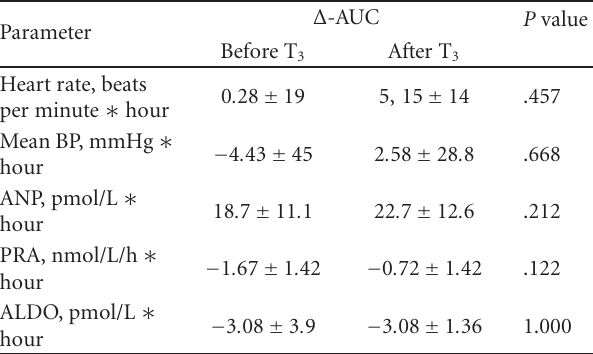
Table 3: Area under the curve di ff erences in clinical and laboratory characteristics following normal saline-induced plasma volume expansion before and after T 3 administration in the study popu- lation.